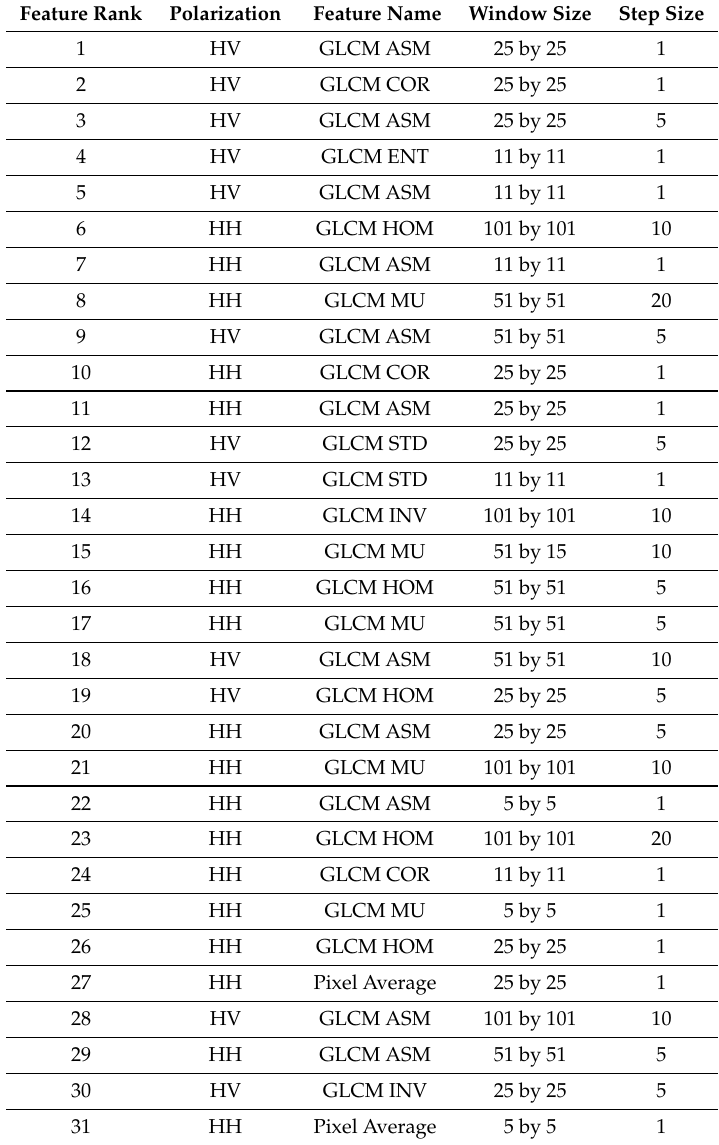
Table 3. List of 31 GLCM and statistical features selected using recursive feature elimination and cross-validation strategy. Window size and step size are shown in